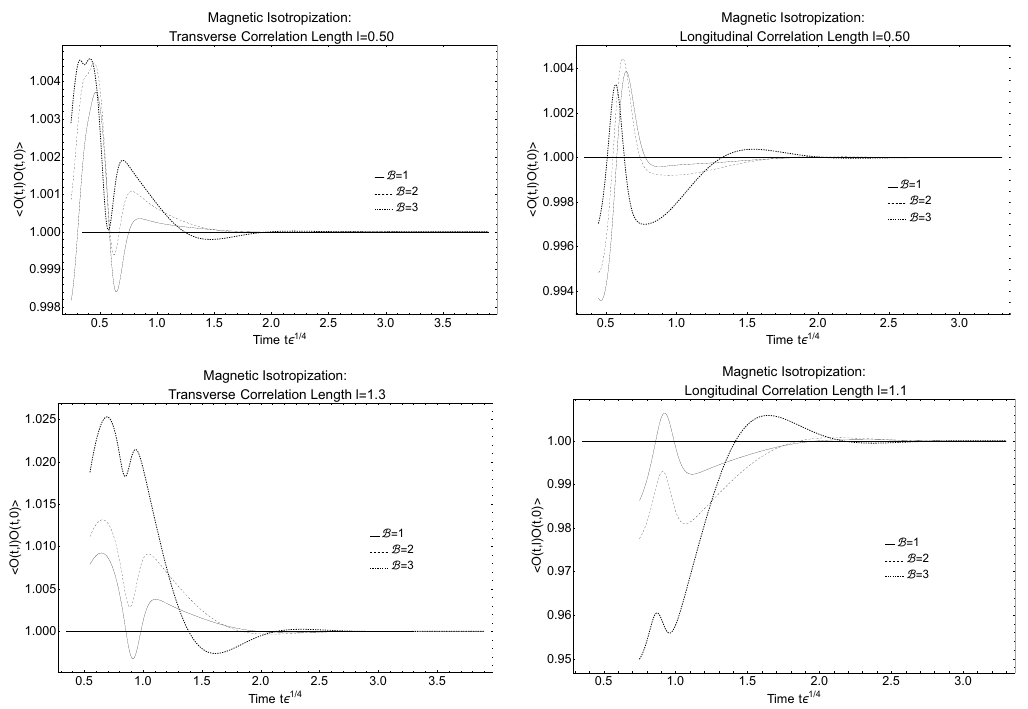
Figure 15 . 2-point correlation functions of an (uncharged) scalar operator in a neutral thermal- izing (cid:13)uid (dual to the evolution towards a magnetic black brane geometry), (cid:26) = 0, B = 1 ; 2 ; 3. Top Left: length separation of l = 0 : 50 in the transverse direction. Top Right: length separation of l = 0 : 50 in the longitudinal direction. Bottom Left: length separation of l = 1 : 1 in the transverse direction. Bottom Right: length separation of l = 1 : 1 in the longitudinal